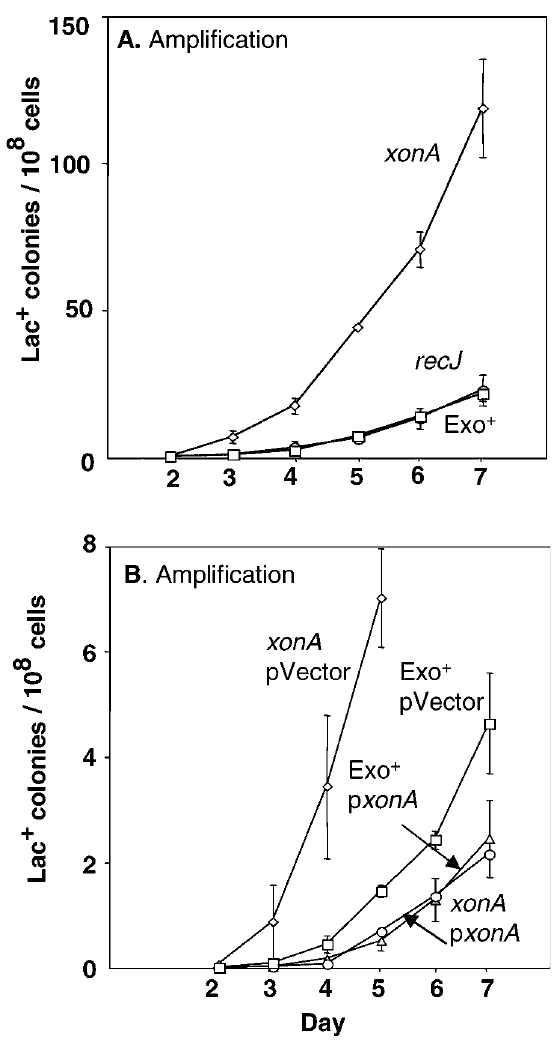
Figure 3. 3 9 -SS DNA Ends Promote Stress-Induced Amplification (A) Deletion of xonA, encoding exonuclease I, causes a 2- to 6-fold increase in amplification. Disruption of recJ, encoding a 5 9 exonuclease has no effect. Thus, increasing cellular levels of 3 9 -SS DNA ends increases stress-induced amplification. The associated strains are as follows: Exo þ (squares), SMR4562; xonA (diamonds), SMR3070; and recJ (circles), SMR690. (B) A plasmid carrying a wild-type xonA gene reduces amplification 2-fold below the level seen with vector alone, and approximately 10-fold